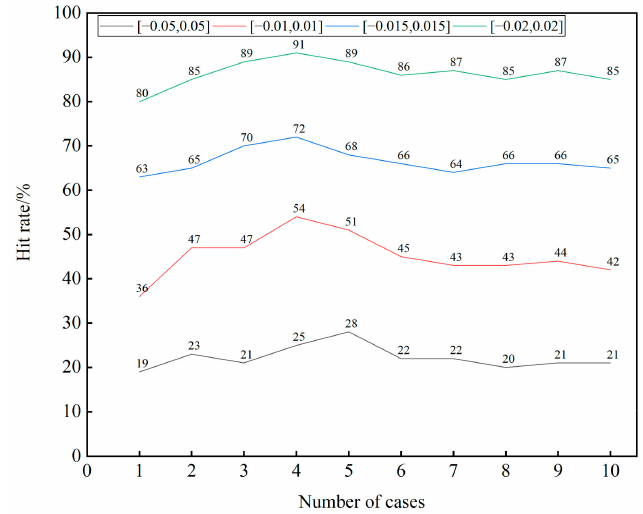
Figure 14. Influence of hyperparameter m on the prediction